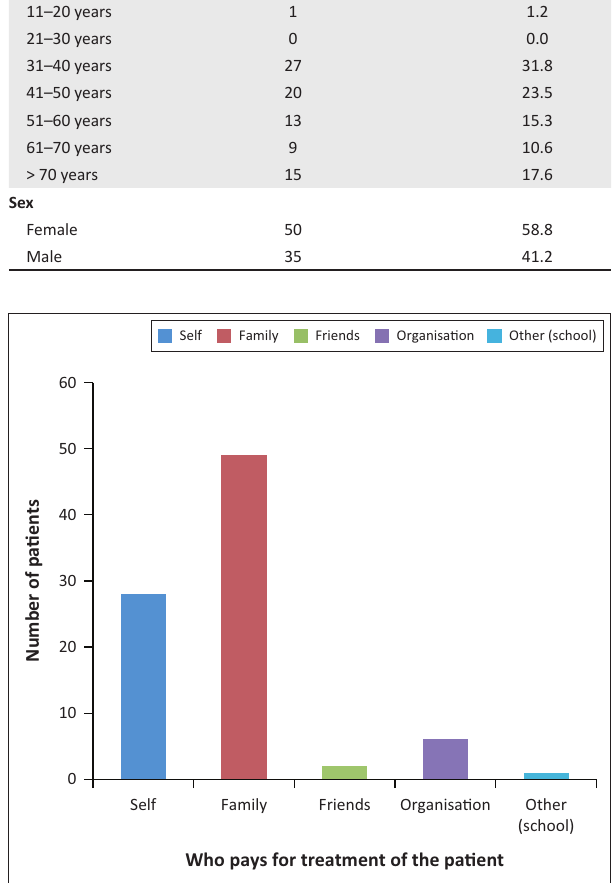
FIGURE 1: Respondents’ response on who pays for their treatment.